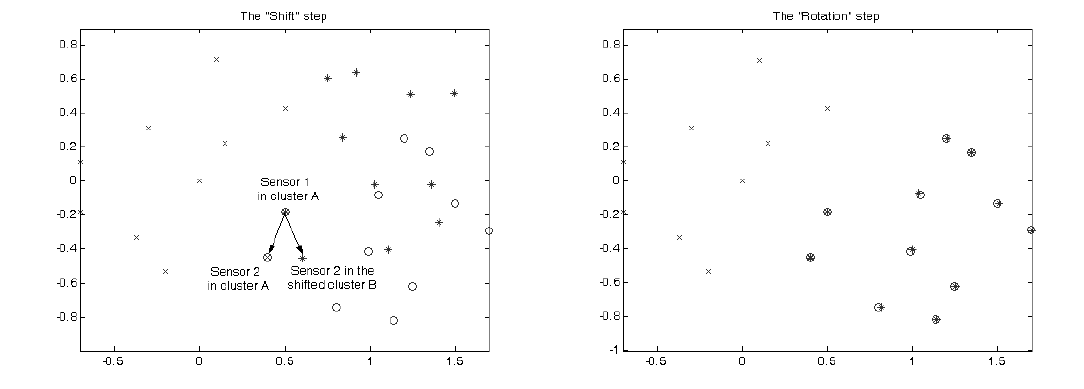
(left); the positions of the merge merge